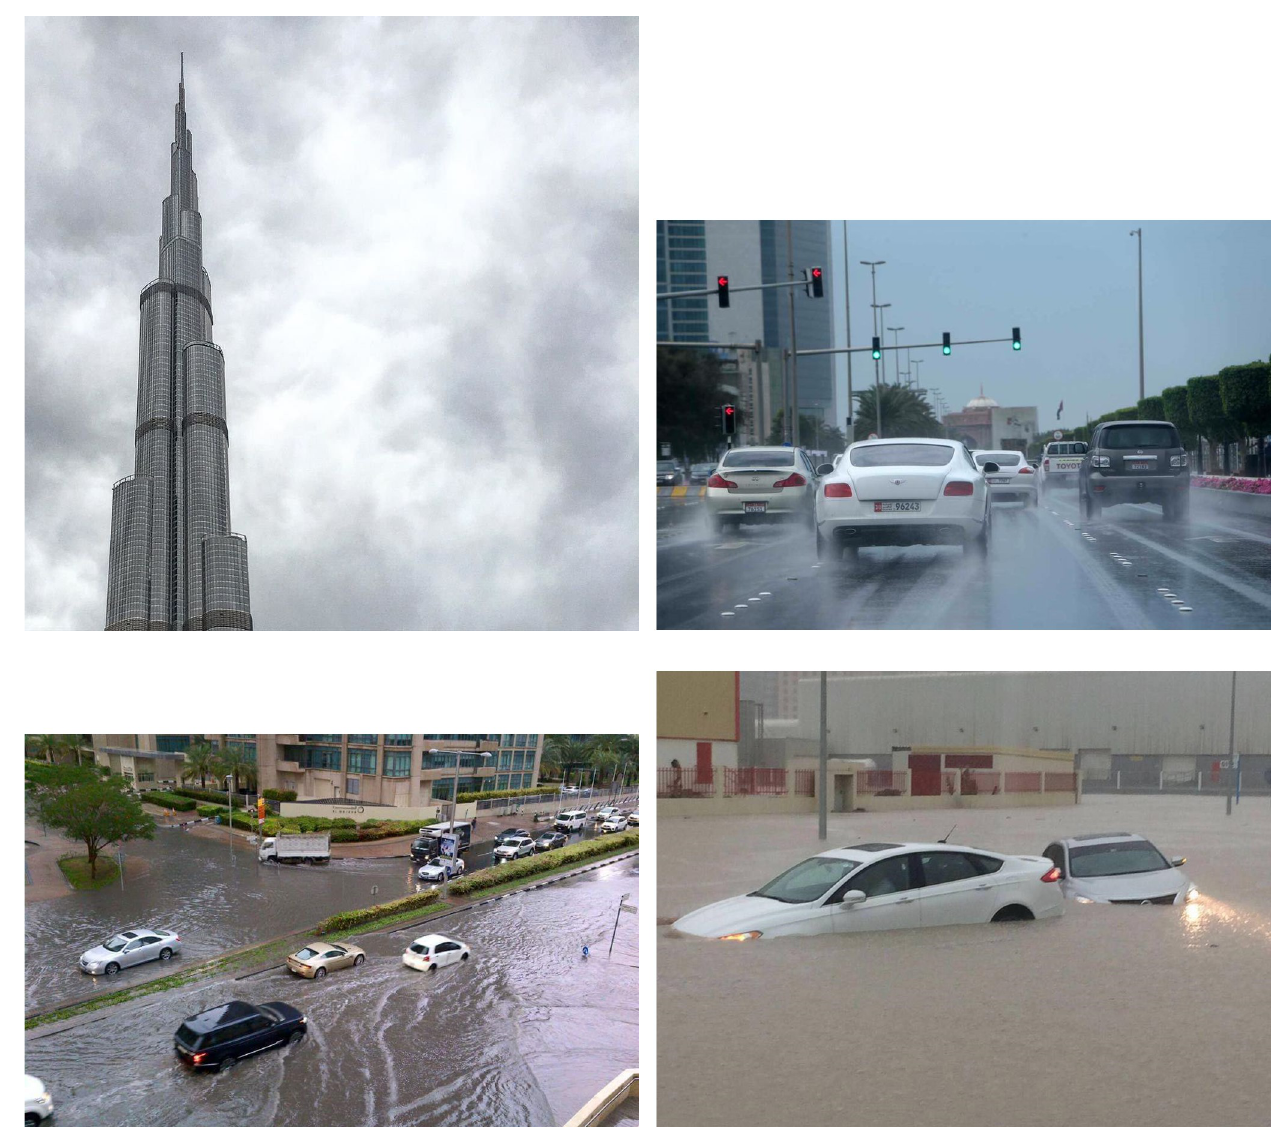
Fig 2. Sample images from final dataset containing classified images based on four classes (a) not relevant, (b) rain, (c) low flood and (d) high